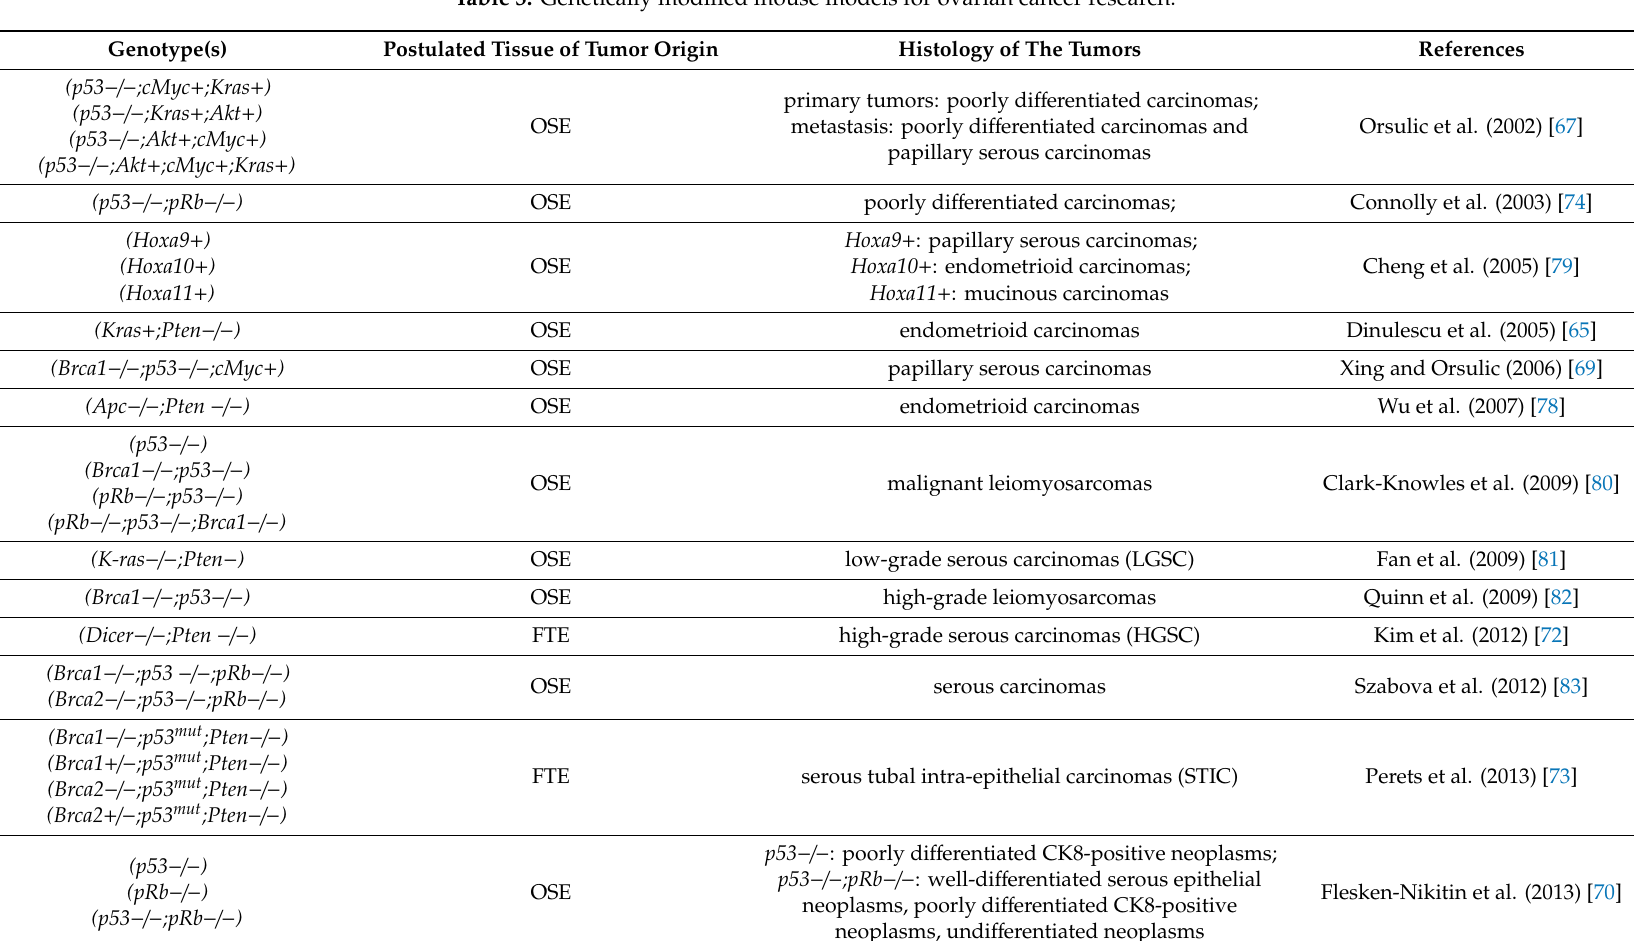
Table 3. Genetically modified mouse models for ovarian cancer